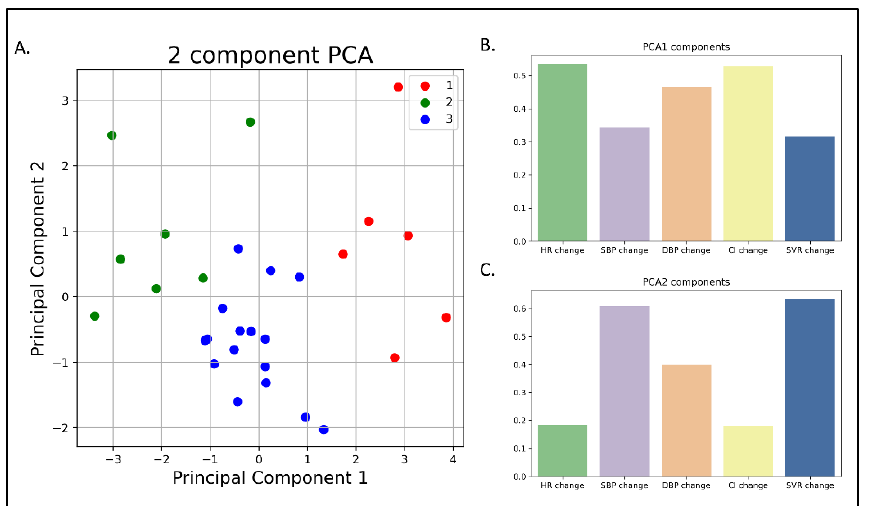
Figure 6. Principal Component Analysis (PCA). ( A ) Graphic representation of a principal compo- nent analysis ( A ) of the three phenotypic clusters. ( B , C ) The different parameters composing the components of the PCA. Table 2. Baseline characteristics between clusters (Ratios or mean ± SD). SVR—systemic vascular resistance; BMI—body mass index; SpO 2 —blood oxygen saturation; ns—not significant; HFrEF— heart failure with reduced ejection fraction; HFpEF—heart failure with preserved ejection fraction; T2DM—type 2 diabetes mellitus; VAS—visual analog scale.